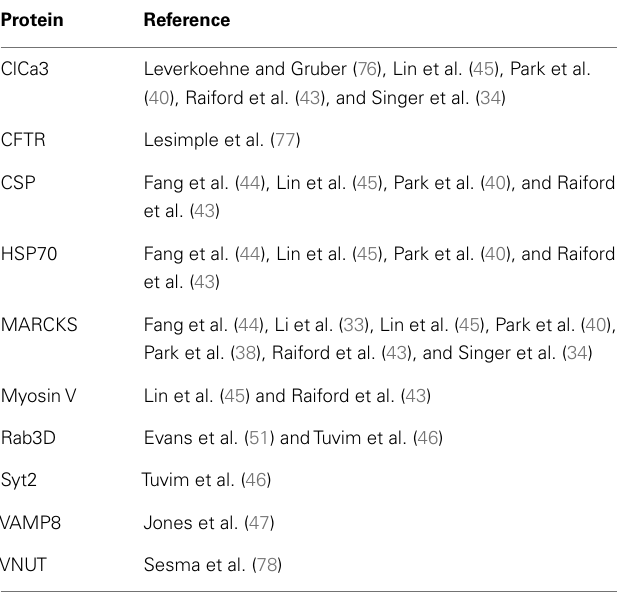
Table 2 | Proteins associated with airway epithelial mucin